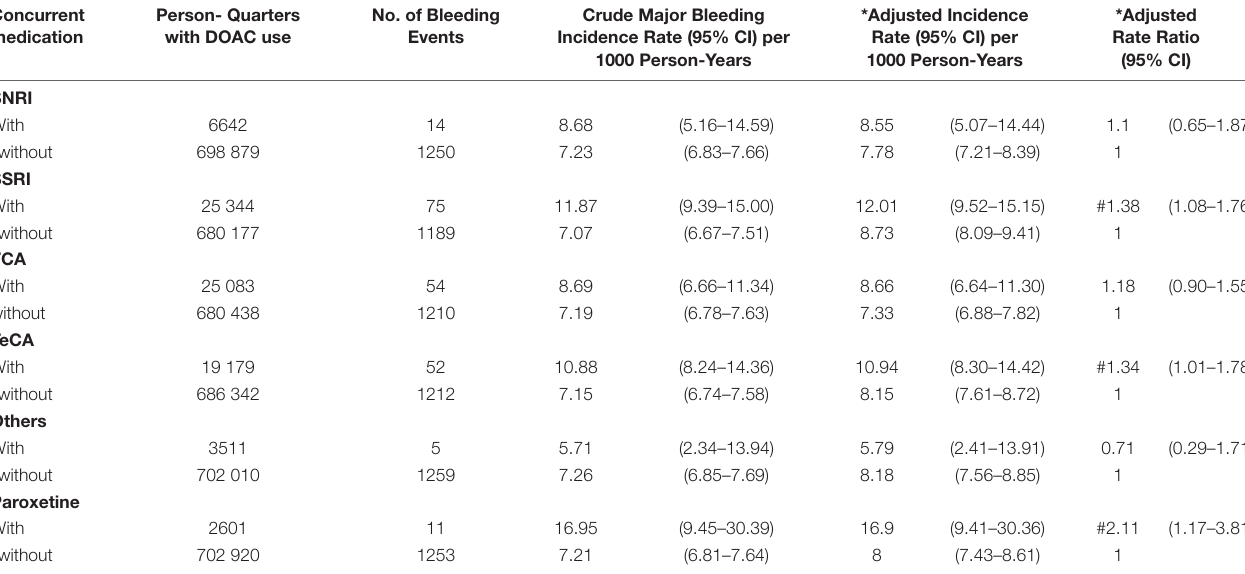
TABLE 4 | Risk of intracerebral hemorrhage among patients with AF taking DOACs with or without concurrent antidepressants. Concurrent Person- Quarters No. of Bleeding medication with DOAC use